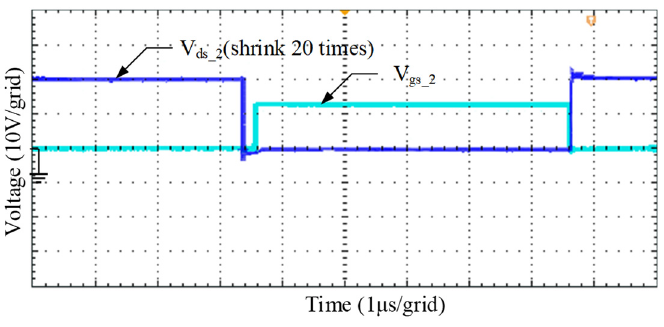
Figure 32. Switching transistor Q2 zero voltage turn-on waveform.